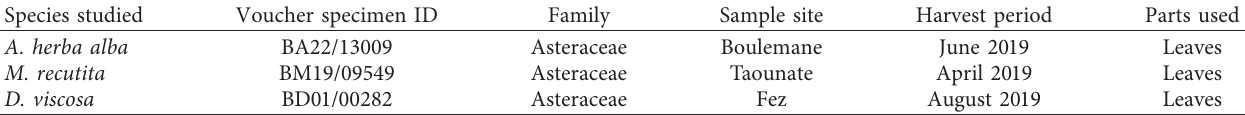
Table 1: Plant species used for the extraction of essential